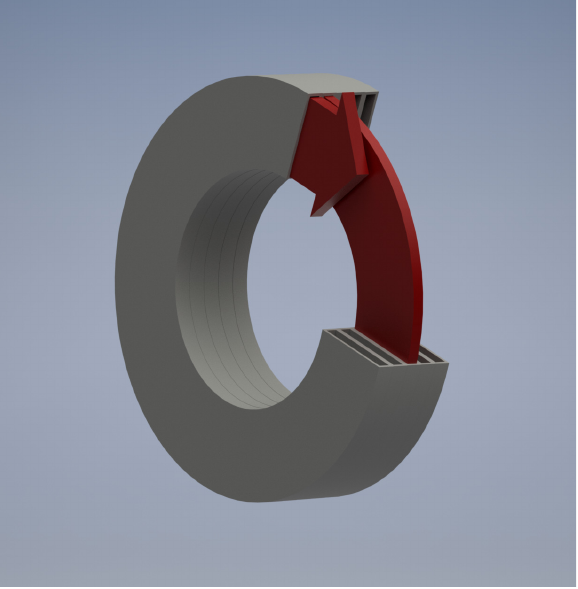
Figure 8. A 3D rendering of the proposed configuration of the ultra-open